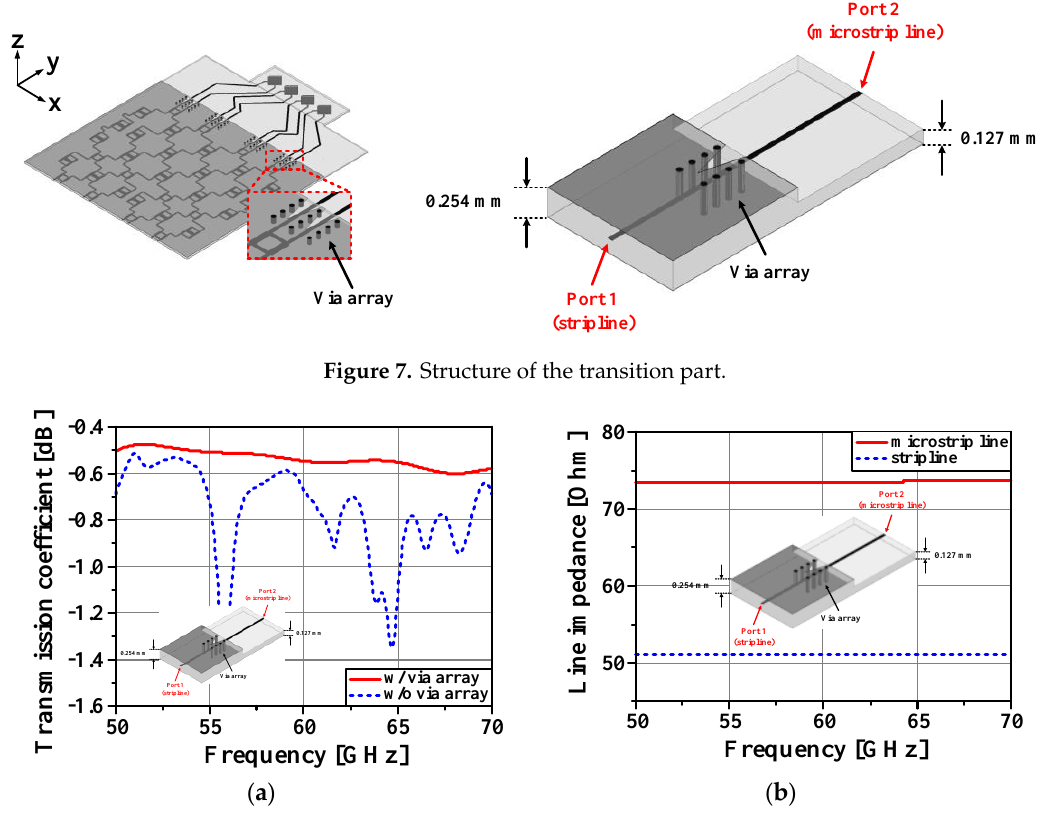
Figure 8. Simulated results of the transition part: ( a ) transmission coefficient with and without series via array and ( b ) line impedance.